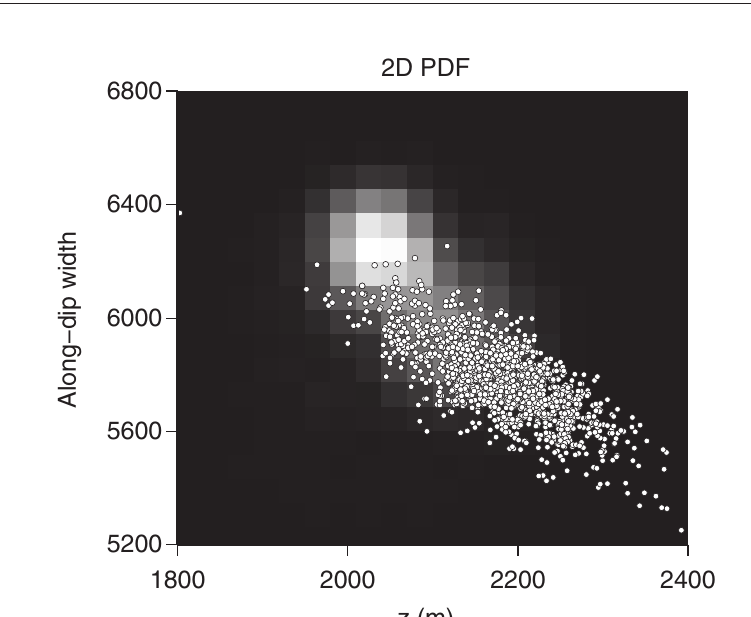
Fig. 6. 2D PDF of fault upper-side depth and along-dip width as obtained using NAB (linear gray scale) and scatter plot from bootstrapping (circles). LHS uniform-slip model.